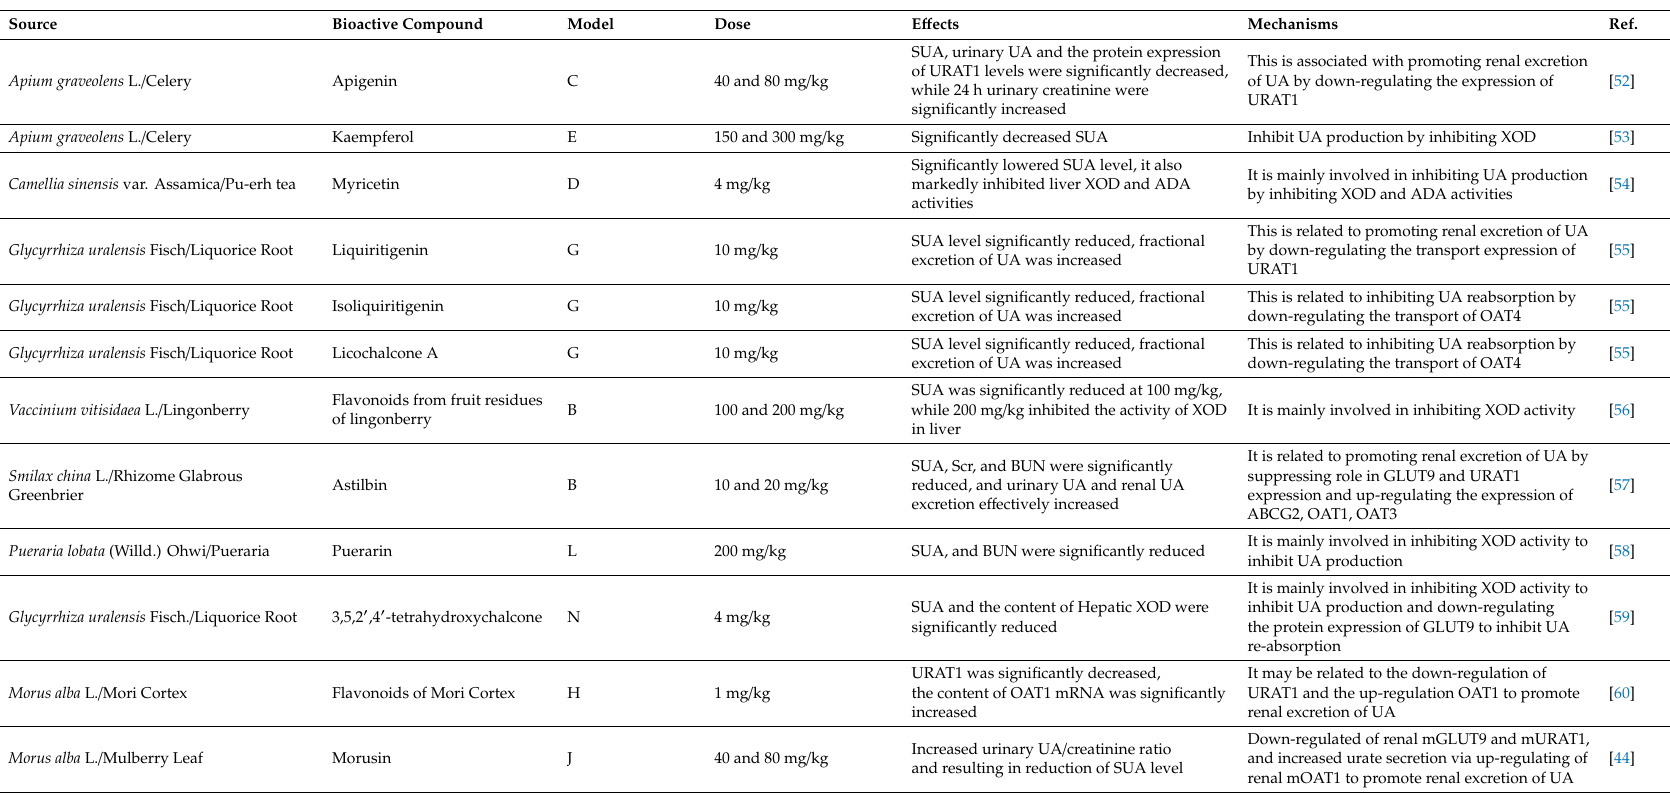
Table 2. Experiment and mechanism of flavonoids bioactive components from plant-based functional foods on